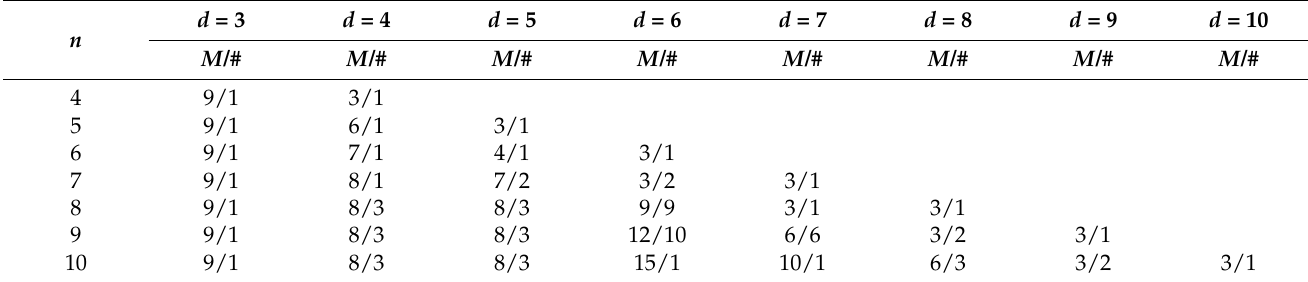
Table 2. Classification of ternary equidistant codes.